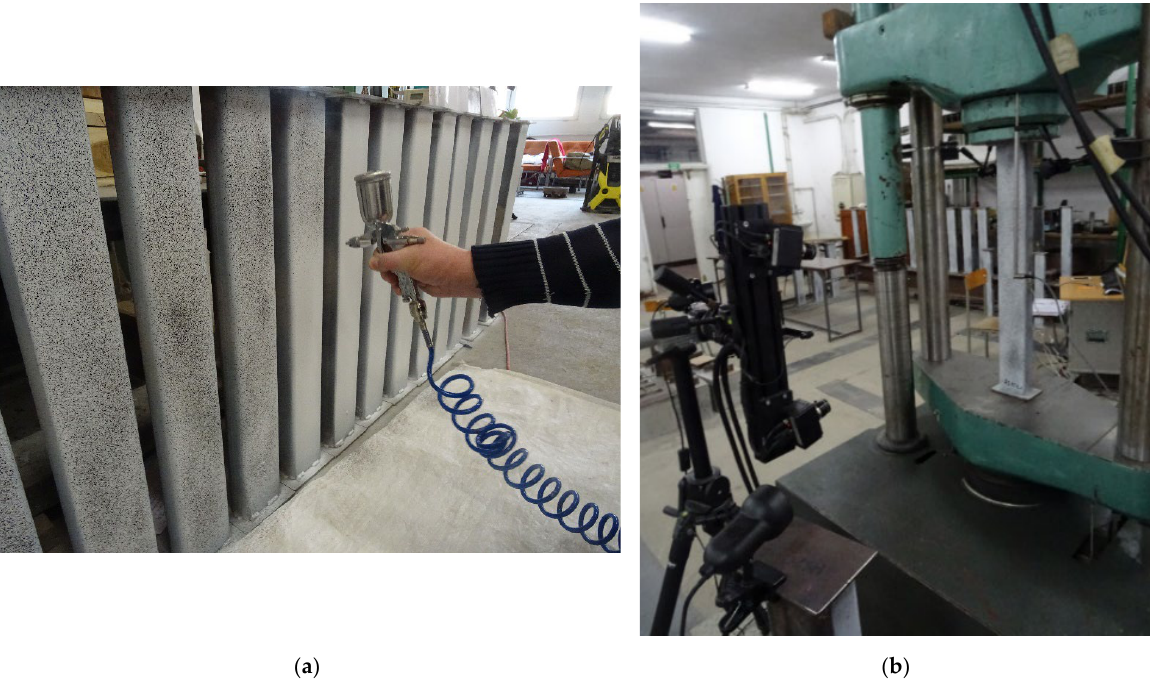
Figure 10. ( a ) Speckle pattern application, ( b ) experimental setup. In order to obtain equilibrium paths in the post-peak parts of the equilibrium paths of columns, a displacement control method was used in the analysis. For technical rea- sons, due to expected exceptionally large deformations of investigated elements and therefore a possibility of uncontrolled ejection of columns from the hydraulic press after buckling, the knife edged boundary conditions simulating pinned-pinned support bound- ary conditions were not used. The test elements were each placed on a rigid, non-deform- able steel plate and compressed by a spherical traverse, embedded in a spherical seat; hence, columns’ ends were partially fixed due to friction. The experimental setup was as shown in Figure 10b. 5. Results of the Experimental Research and Discussion 5.1. Failure Modes The typical failure modes of the analyzed columns are shown in Figure 11. Three types were observed: a combination of global and local buckling (from this point called only the global buckling), local shear and sliding, and elephant foot (splitting) failure. Global buckling occurred in all slender columns from series A (Figure 11a) and in one specimen, BS1C2_1, from series B (Figure 11b). In all remaining slender columns from series B, the failure occurred due to the local shear and sliding of the concrete core (Figure 11c). In only one moderately slender specimen, DS2C1_1, was elephant foot (splitting) failure observed (Figure 11d). The failure of all remaining specimens from series D oc- curred due to shear and sliding of inner concrete (Figure 11e).